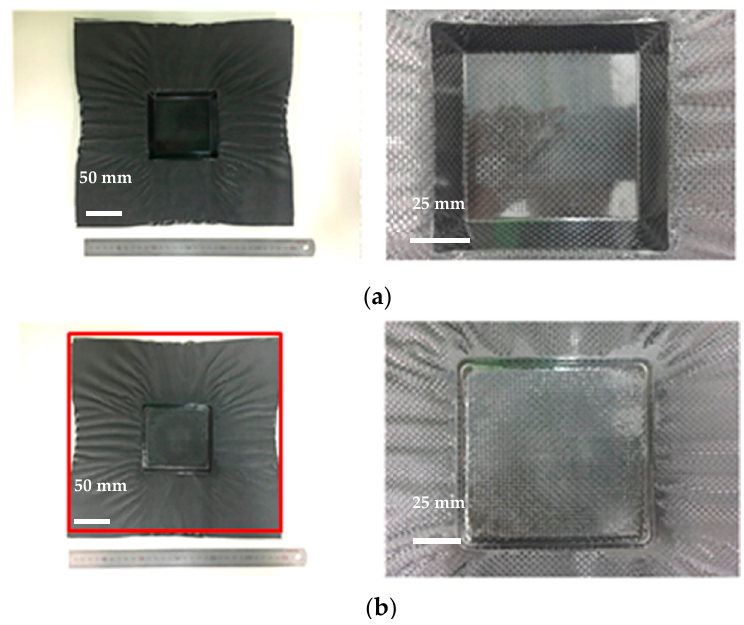
Figure 6. ( a ) Inner layer and ( b ) outer layer of the thermoformed square-cup for the Type 1 mold design with the pattern 1 prepreg laminate.